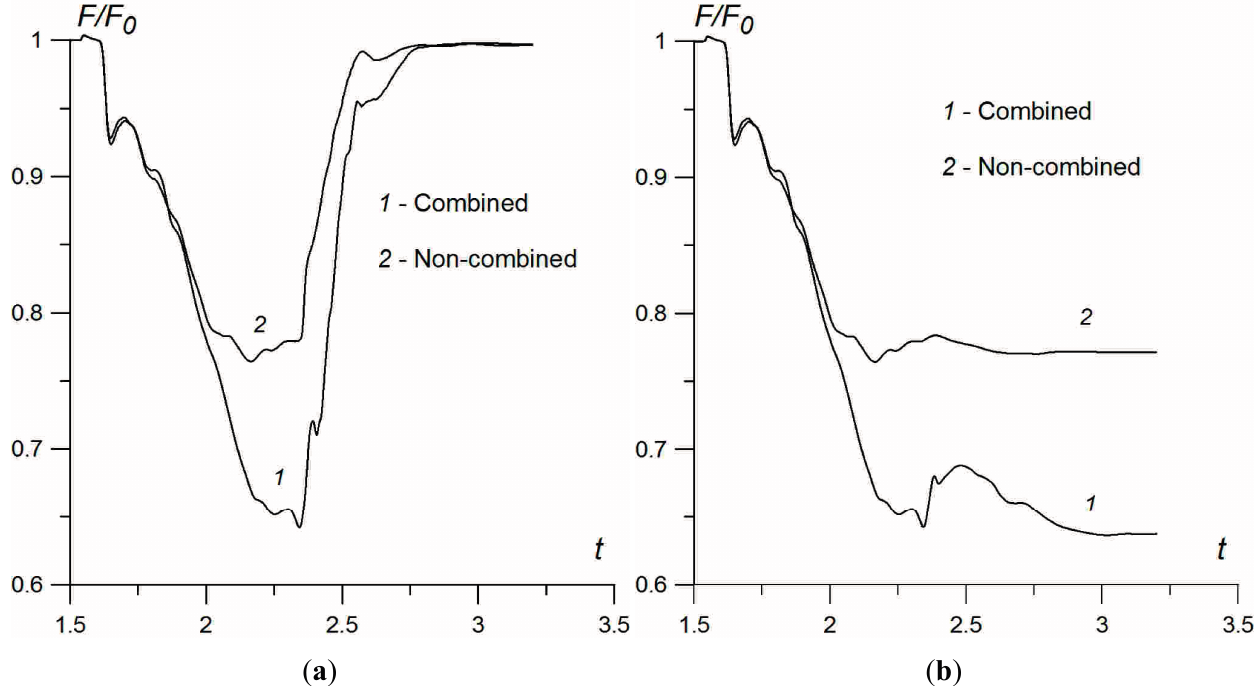
Figure 9. Dynamics of dimensionless frontal drag force, M = 3.45, α ρ = 0.5, α ρ 1 = 0.35: ( a ) Bounded filaments; ( b ) Infinite